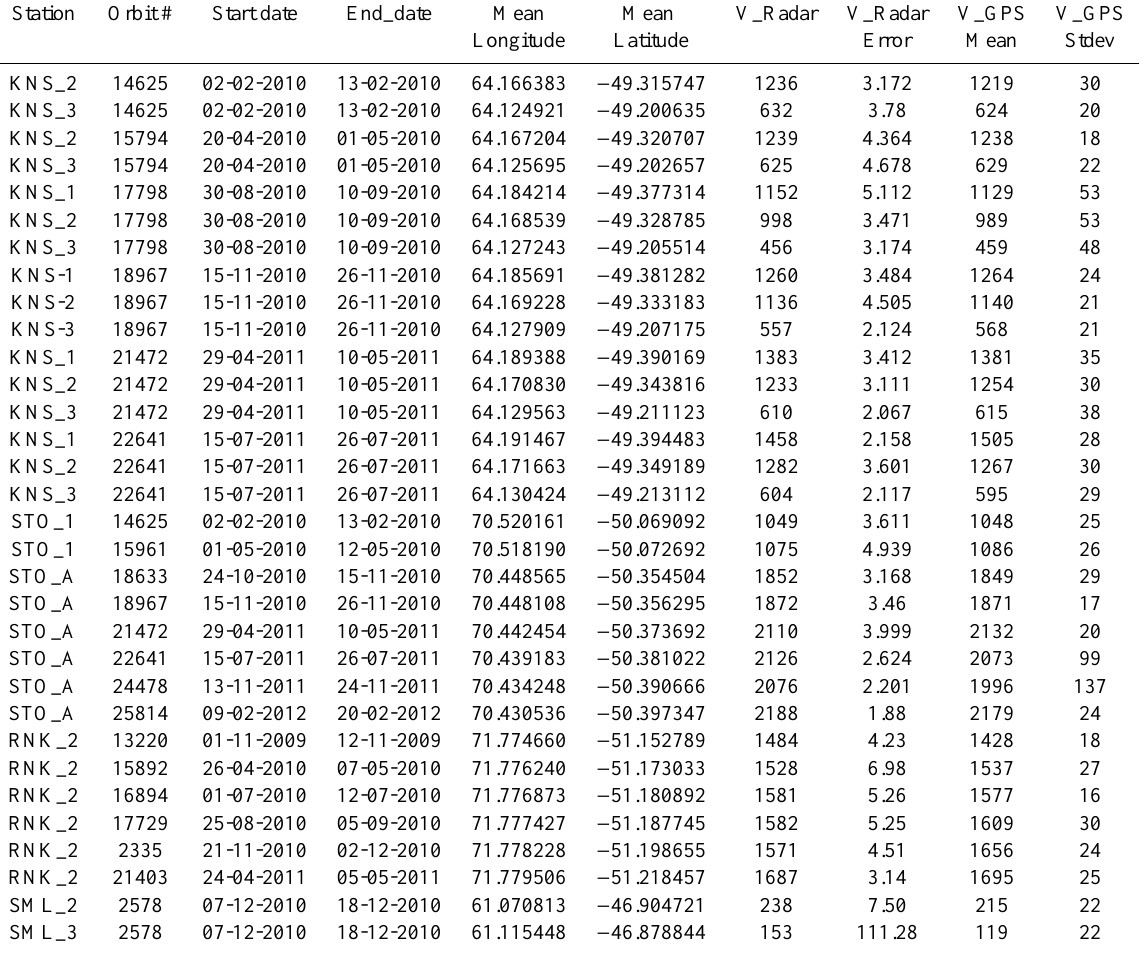
Table 4. Comparison of ice velocities derived by APL from TerraSAR-X satellite radar imagery and ice velocities from GPS measurements. Ice velocities are given in myr − 1 , latitudes and longitudes in decimal degrees N and W, respectively, using the World Geodetic System 1984